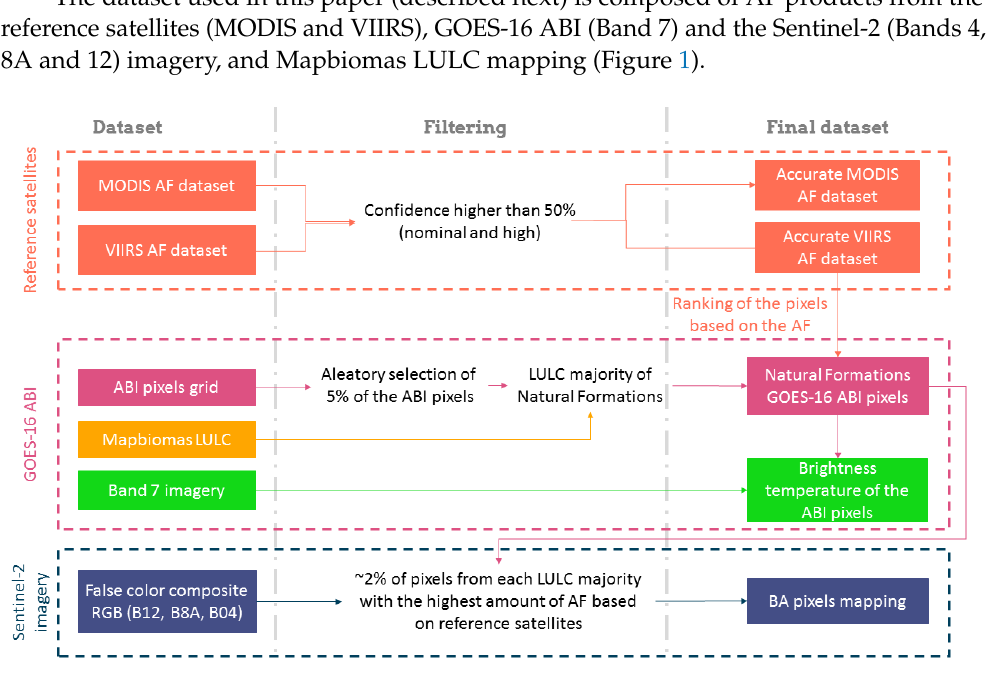
Figure 1. Dataset used and the filtering process of the data. AF: Active Fire; LULC: Land Use and Land